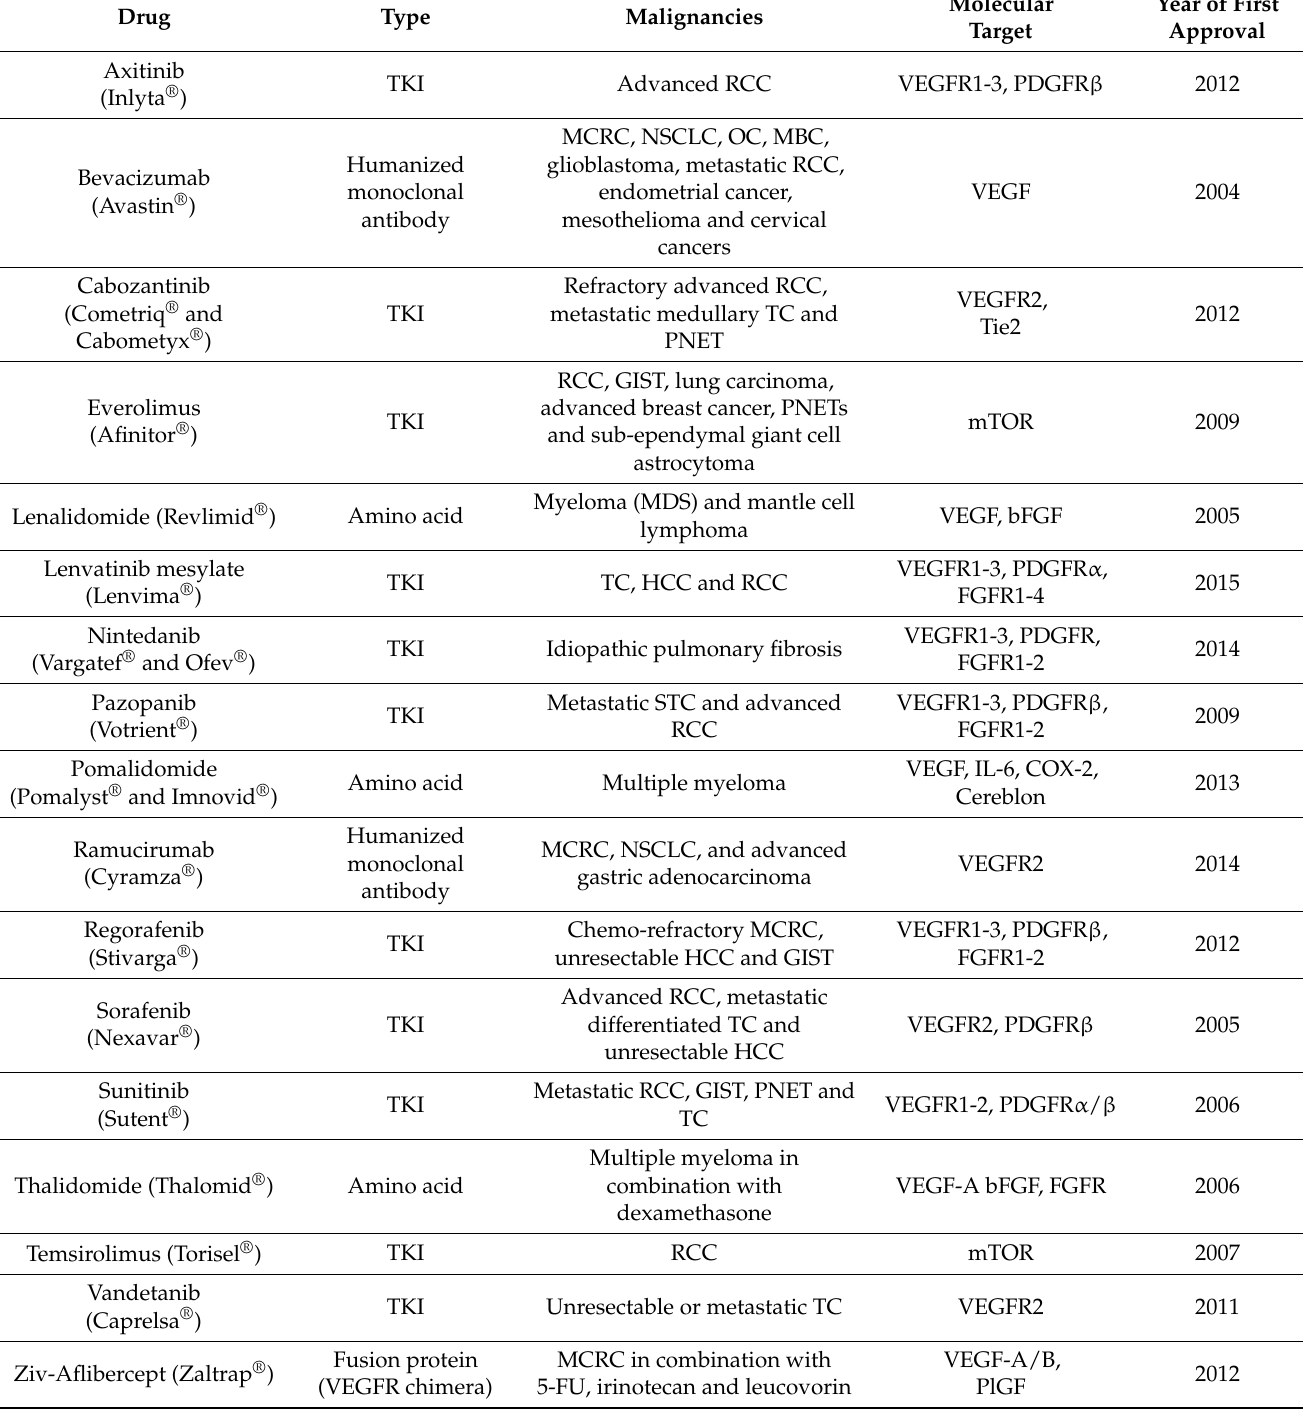
Table 1. Antiangiogenic drugs approved by the FDA for the treatment of solid